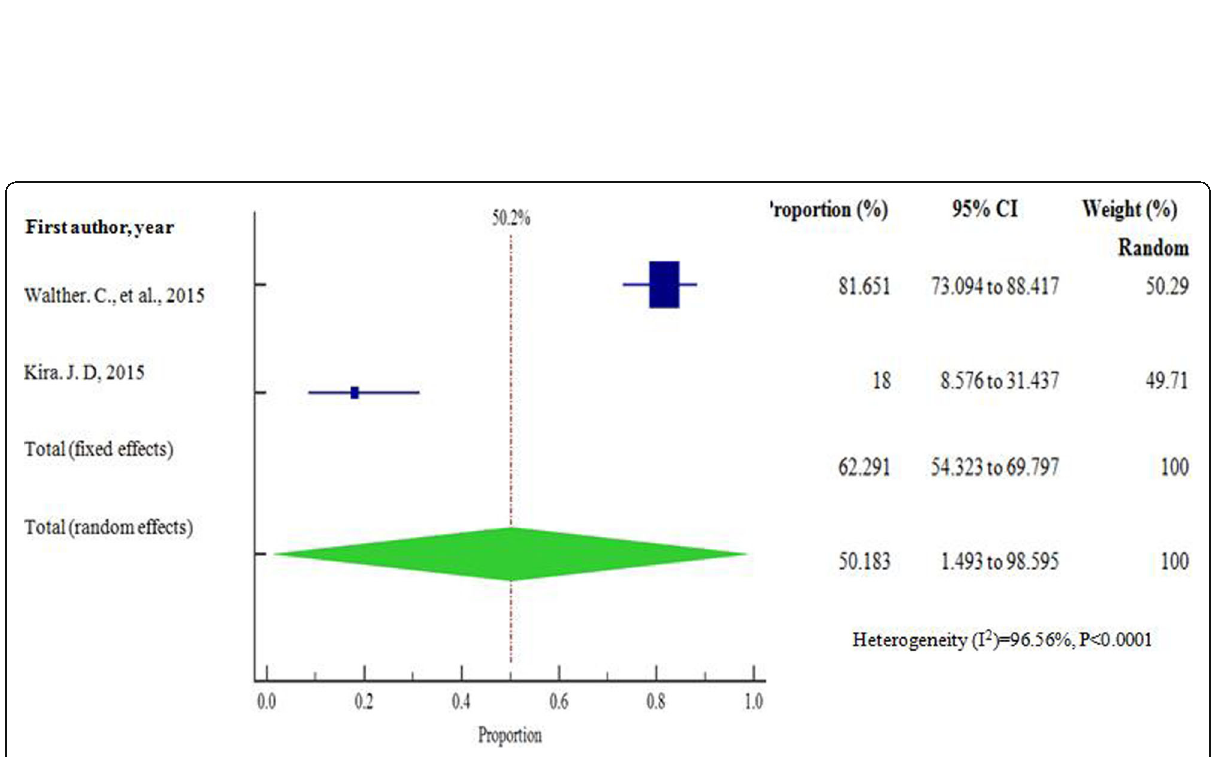
Fig. 6 Pooled prevalence estimates of bacterial contamination in herbal medicines sold in Tanzania from the year 2000 to 2020, using random effects